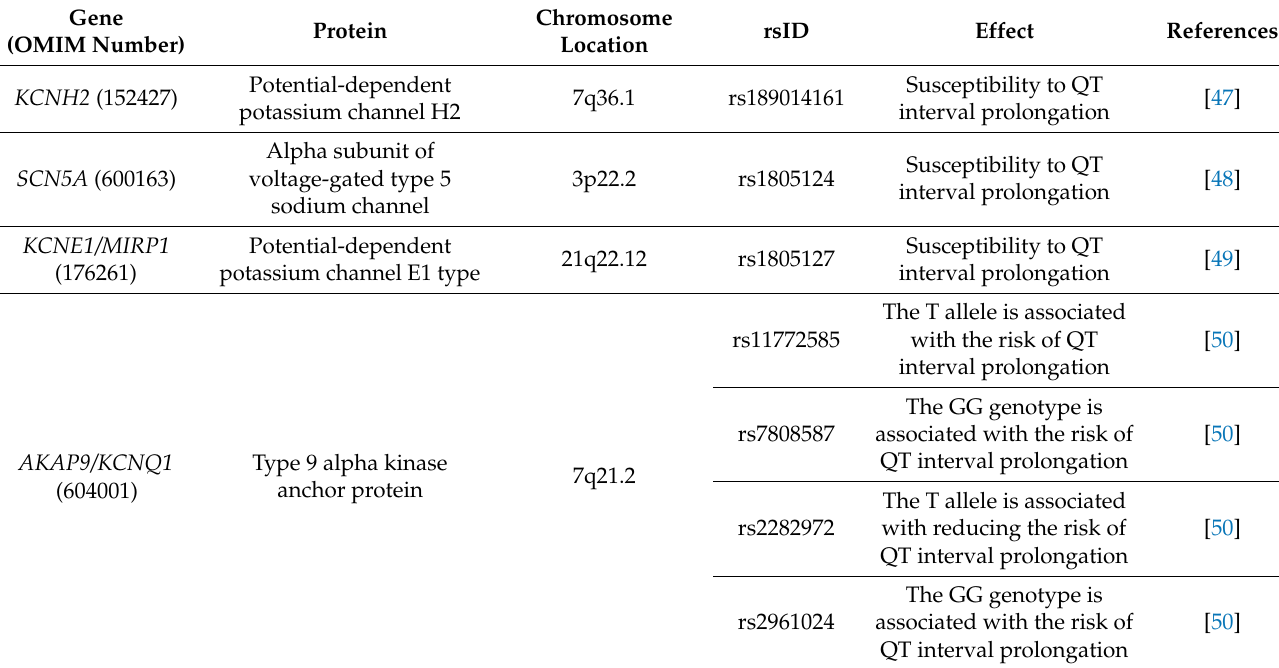
Table 3. Candidate genes and their single nucleotide variants predisposing to QT prolongation.